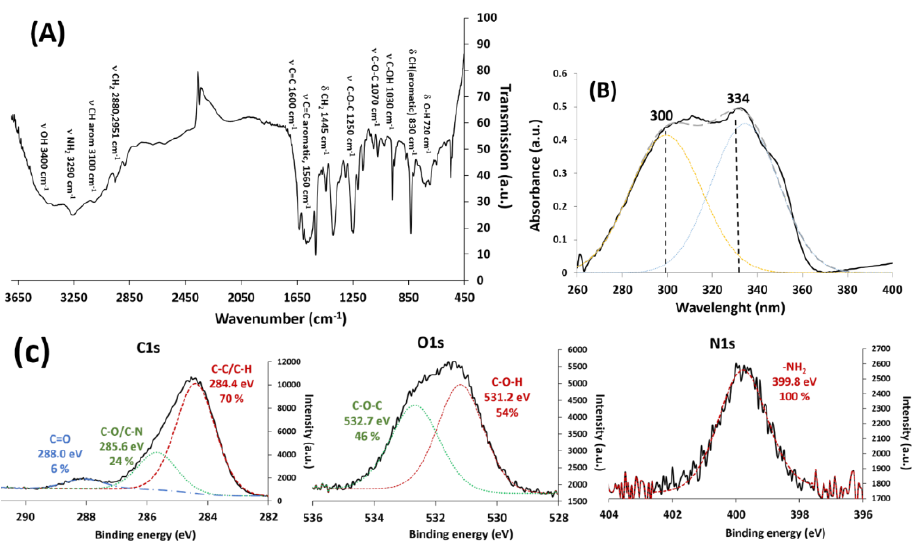
Figure 3. ( A ) Fourier-transform infrared (FTIR) spectrum, ( B ) UV-visible spectrum, and ( C ) fitted X-ray photoelectron spectroscopy (XPS) spectra of C1s, O1s, and N1s peaks of the synthesized RSV derivative molecule (HAPtS).